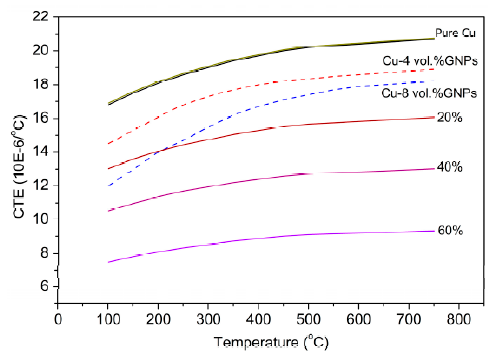
Figure 15. The theoretical predictions and experimental coefficient of thermal expansion of pure copper, Cu-4 vol % GNPs, and Cu-8 vol % GNPs as a function of temperature [142], Reproduced from [142], with permission from Springer Nature, 2018.